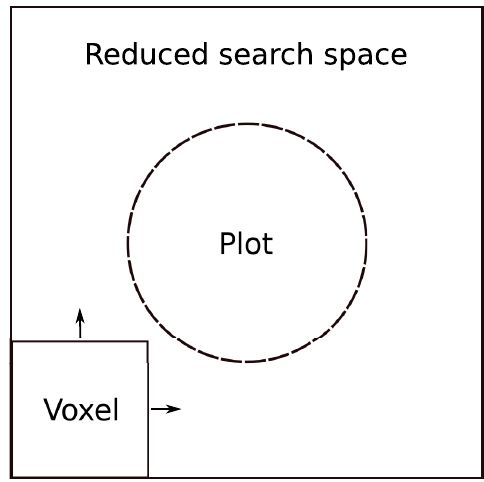
Figure 7. Speeding up processing by confining the search space (plan view). The arrows indicate horizontal voxel